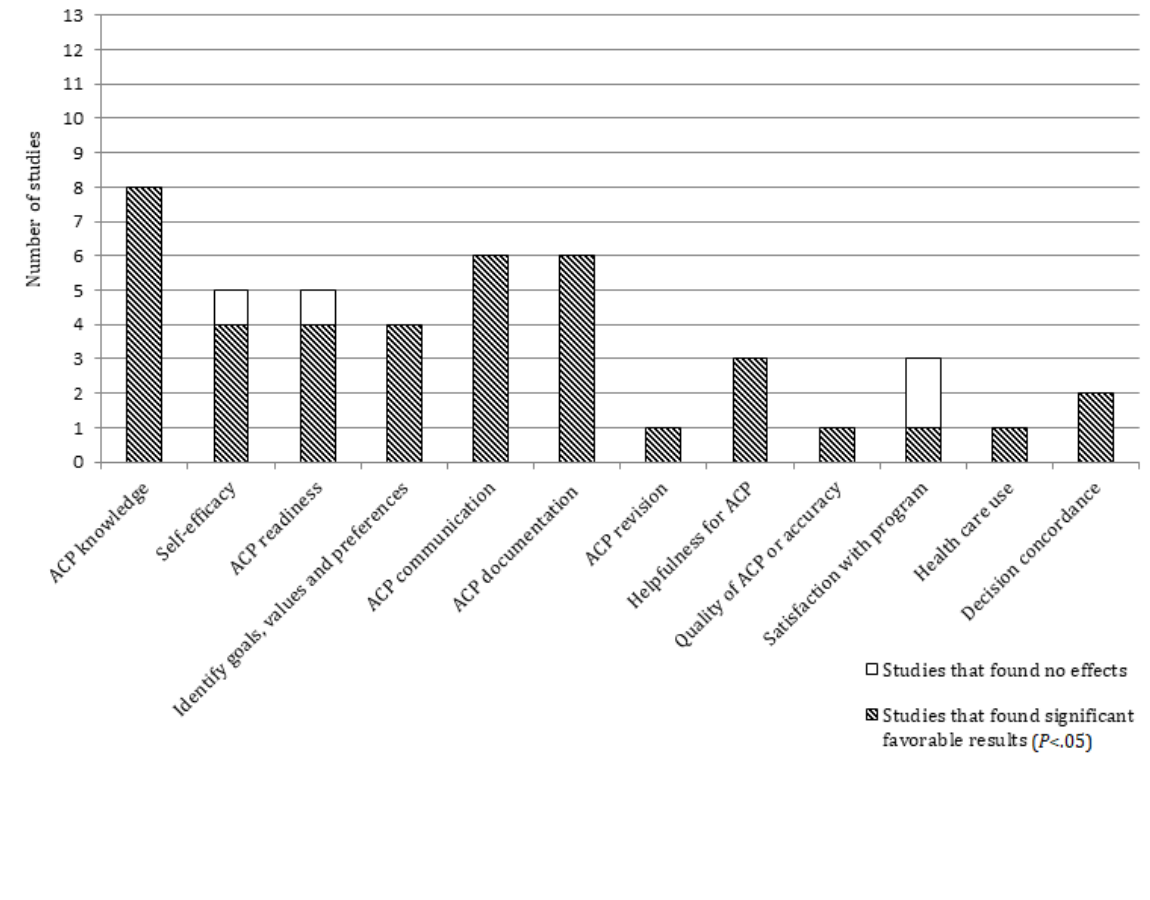
Figure 2. Results of quantitative studies assessing the effectiveness of Web-based advance care planning programs comparing the intervention group (Web-based advance care planning program) with baseline or control groups (N=13). ACP: advance care